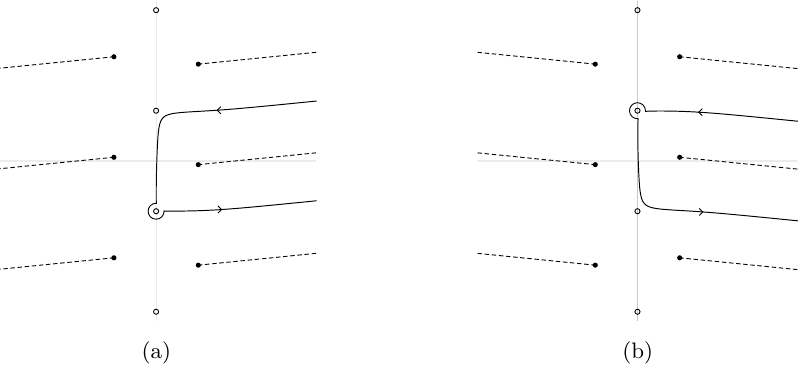
Figure 8. Singular reflected saddles ( Re( η ) < w ) . η should be shifted off the real axis for the saddle-point expansion to be well-defined. Compared to figure 6, η has been given a small positive phase on the left and a small negative phase on the